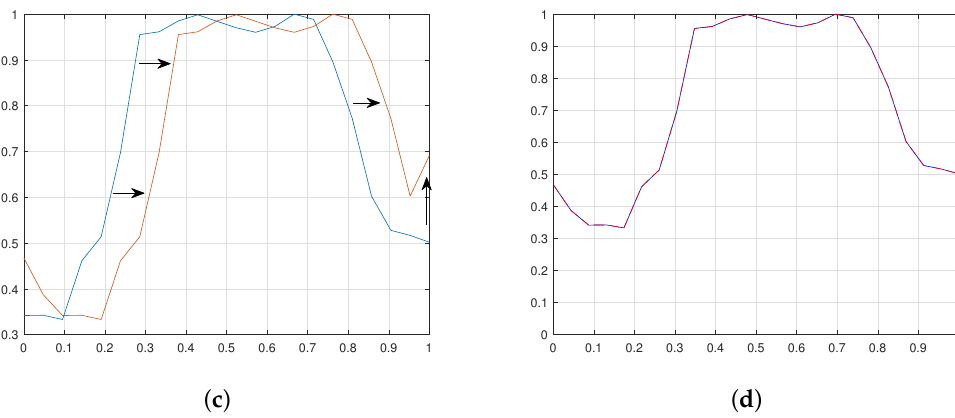
Figure 9. Four classes of load in VPP optimization problem. Blue profile is the uncontrolled profile; red profile is the profile with implemented control. ( a ) L1 (sheddable load); ( b ) L2 (shiftable and sheddable load); ( c ) L3 (shiftable load with daily conservation); ( d ) L4 (non-controllable load). Please note that in (d) the two profiles completely